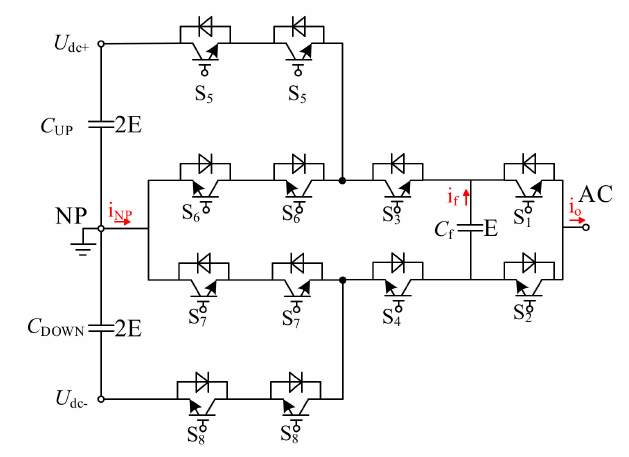
Figure 1. Topology of the ANPC-5L